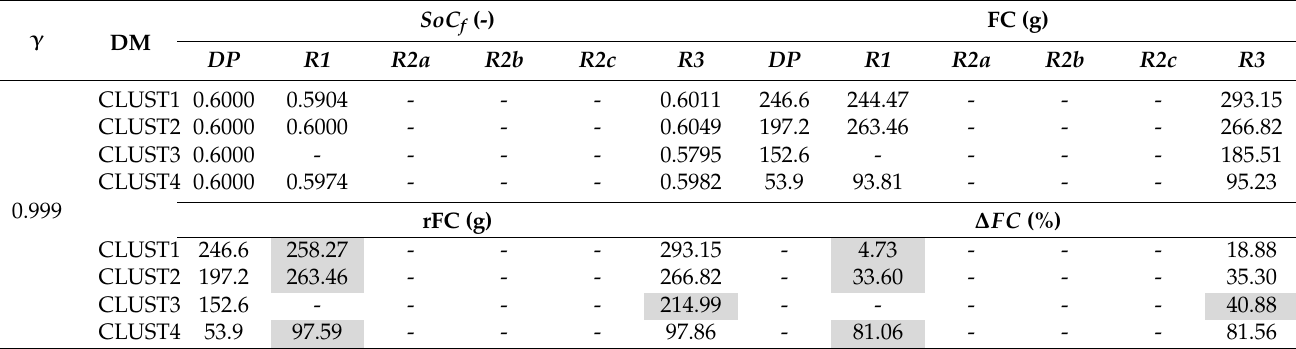
Table 5. Reward shaping analysis considering γ =